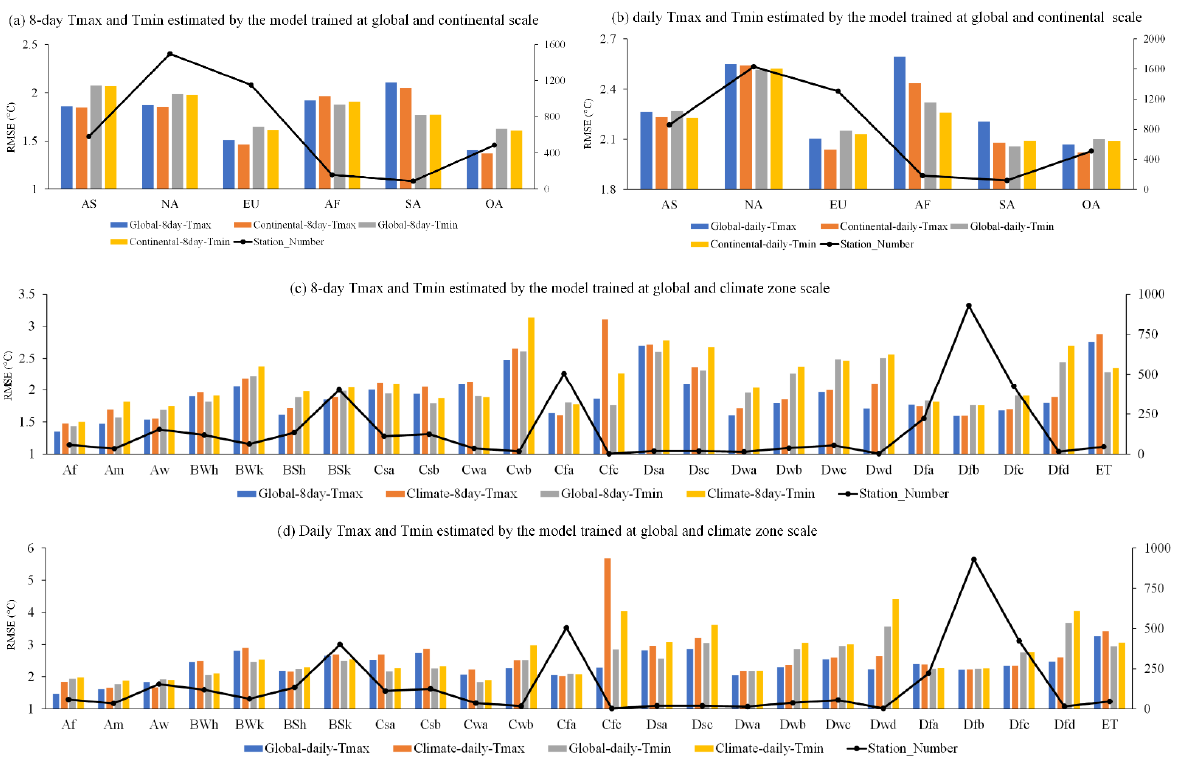
Figure 5. The averaged cross-validated estimation accuracy of 8-day ( a , c ) and daily ( b , d ) Ta in spatial experiments using the models trained at global and continental scale ( a , b ) or global and climate zone scale. Global/Continental/Climate -8 day/daily-Tmax/Tmin means using the model for 8-day/daily Tmax/Tmin estimation trained on a global, continental and climate zone scale (corresponding continents or climate zone), respectively.